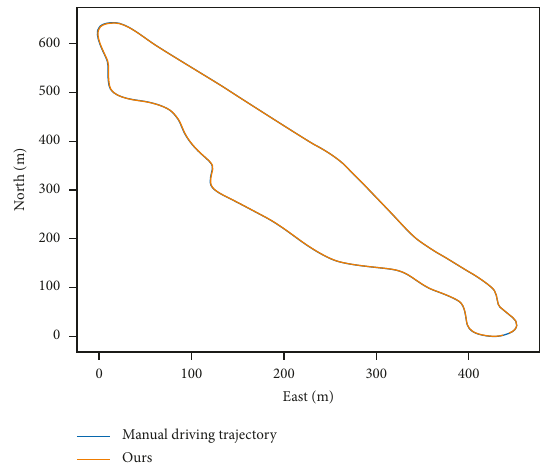
Figure 12: Recorded locations of the vehicle during the real environment test.